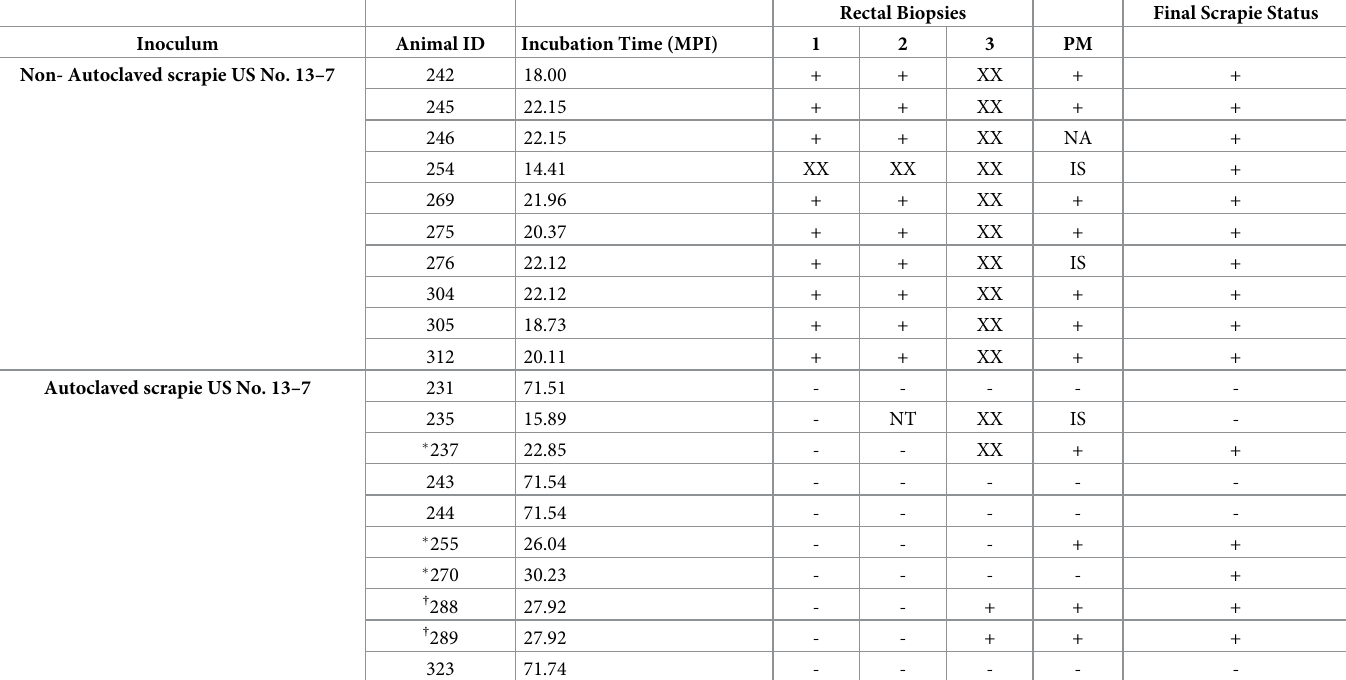
Table 2. Immunohistochemistry of antemortem serial rectal biopsies.